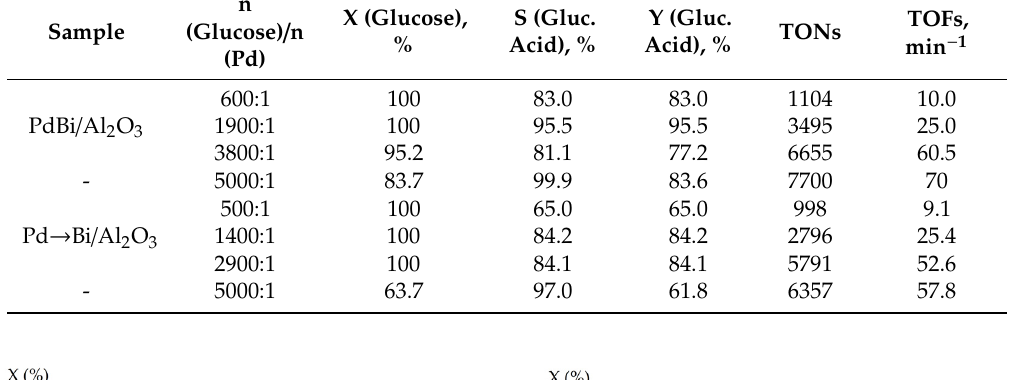
Figure 12. Dependence of glucose conversion (X) on time (t) in the presence of the catalyst ( a ) PdBi/Al 2 O 3 ( b ) Pd → Bi/Al 2 O 3 .